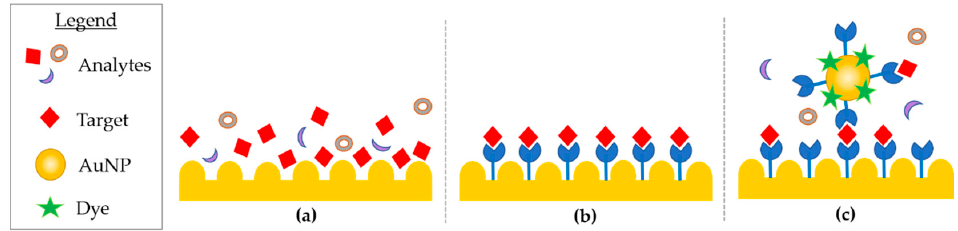
Figure 3. ( a ) Direct, ( b ) indirect, and ( c ) extrinsic